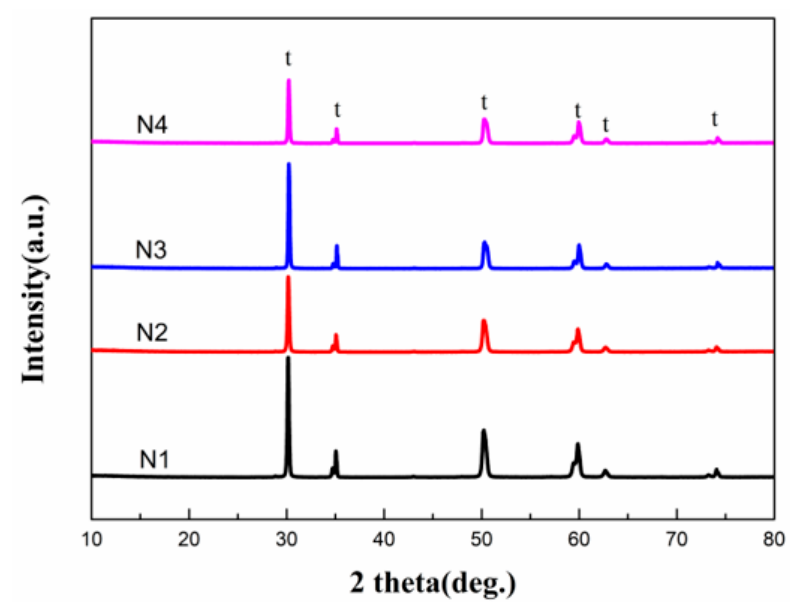
Figure 2. XRD patterns of samples.